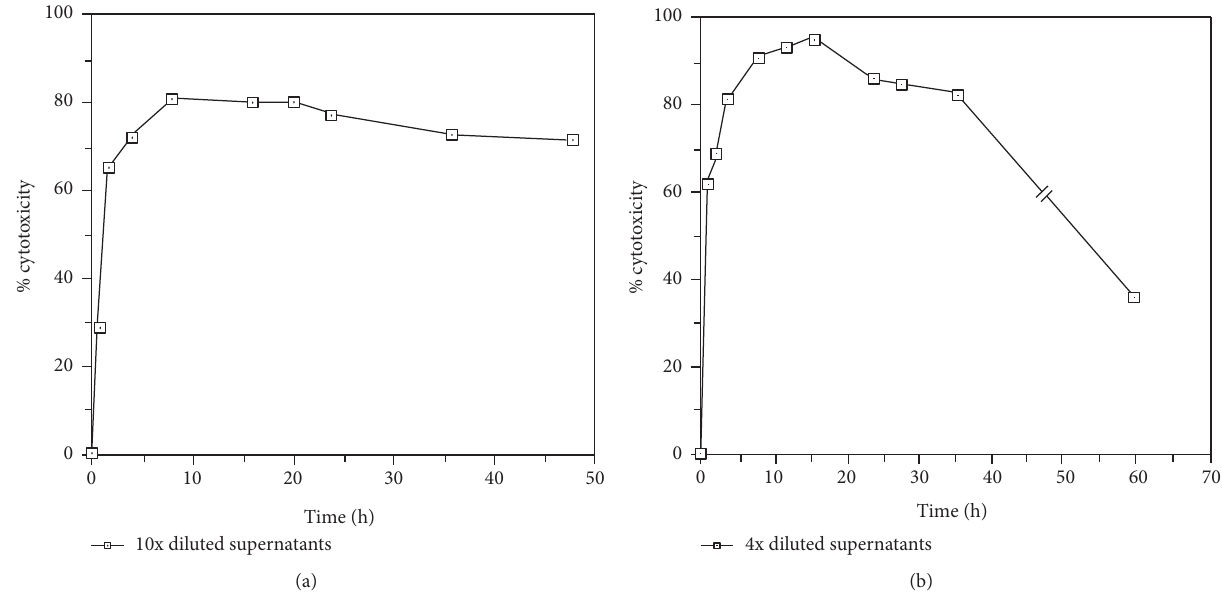
Figure 3: (a) Time course of TNF cytotoxicity produced by AMC cultured in complete RPMI-1640 containing 0.02 𝜇 g/mL LPS. Crude supernatants were harvested at time indicated and TNF cytotoxicity in 10x diluted cell-free supernatants was analyzed. (b) Time course of TNF cytotoxicity produced by AMC activated under 1h of 0.02 𝜇 g/mL LPS stimulation. Crude supernatants were harvested at time indicated and TNF cytotoxicity in 4x diluted cell-free supernatants was